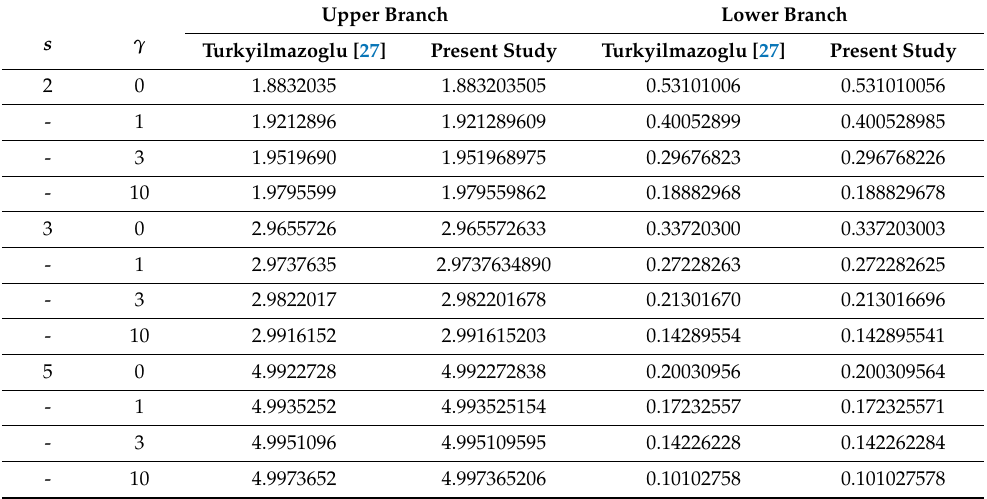
Table 2. Comparison of numerical values of solution β as a function of s and γ when ϕ 1 = 0 = ϕ 2 = k 1 , λ = − 1 = δ